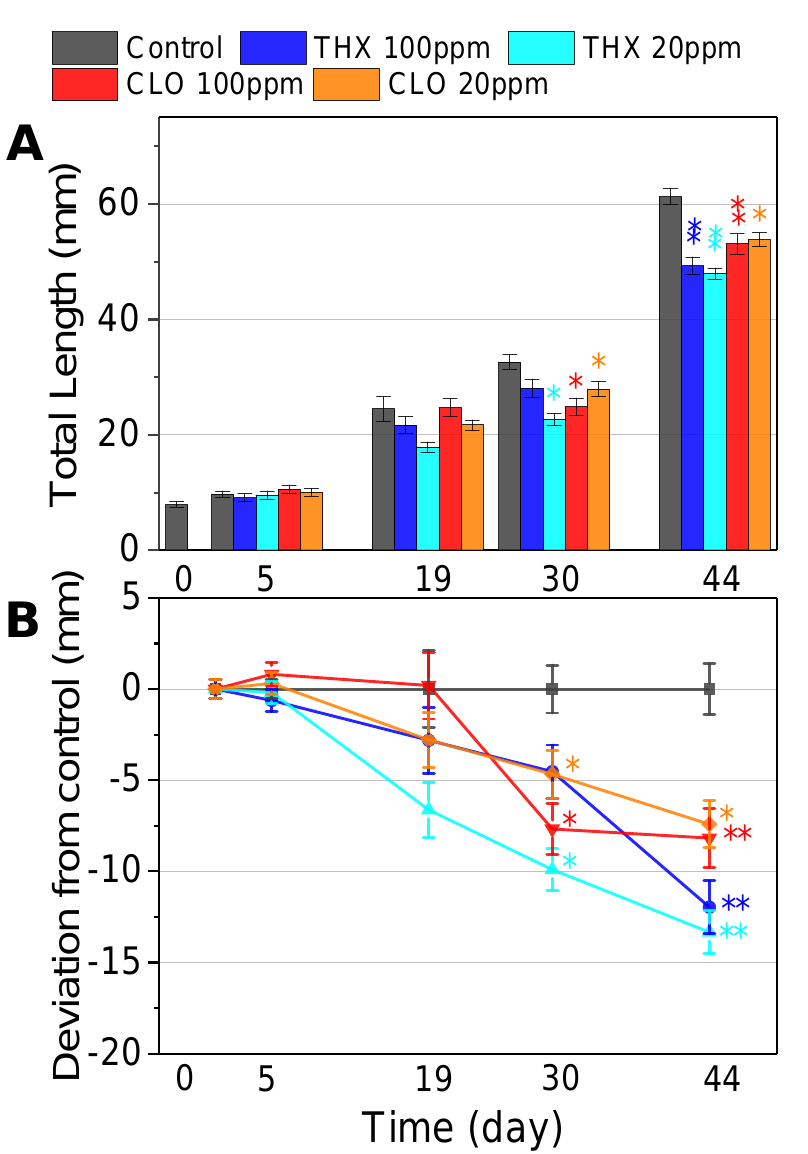
Figure 1. ( A ) Average total lengths (SE) of tadpoles ( Xenopus laevis ) measured incrementally from day 1 to day 44 post-hatch. Tadpoles were exposed in vivaria to thiamethoxam (THX), clothianidin (CLO), or pesticide-free control media. Lengths were measured from photographs of all individuals in each vivarium per treatment group ( n = 4 replicate vivaria per treatment group). One asterisk indicates significant difference from control by ANOVA at the day of sampling, and two asterisks indicate significance by ANOVA and MANOVA (days 30 and 44). ( B ) The difference in tadpole lengths (SE) within treatment groups are plotted relative to control lengths.